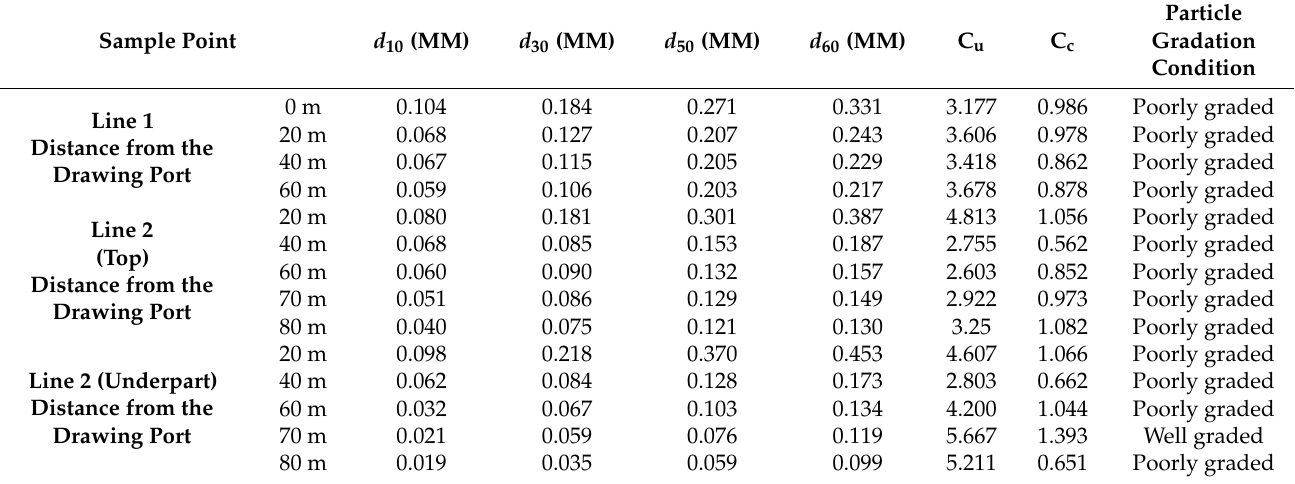
Table 2. Classification parameters of tailings.